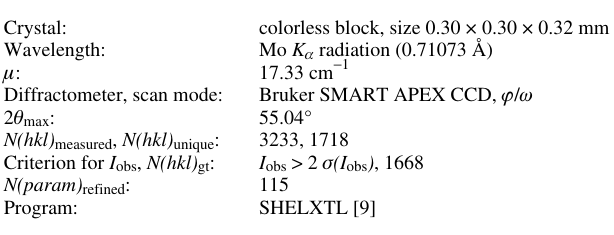
Table 1. Data collection and